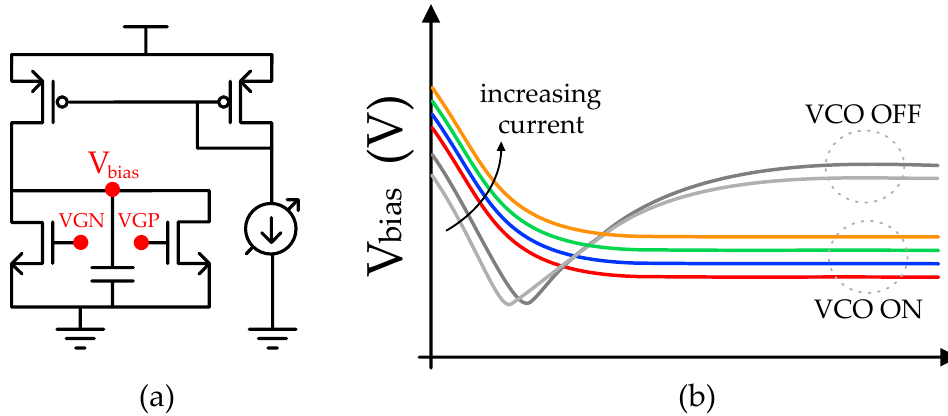
Figure 2. ( a ) Conventional structure of bias circuit for Class-C VCO and ( b ) its transient response of bias voltage for different current levels.